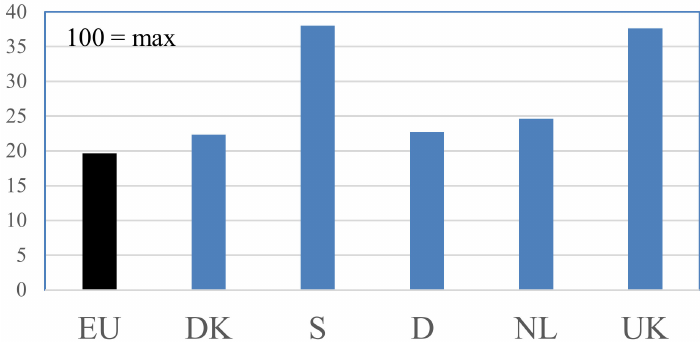
Figure 2. Comparison of aggregated Benchmark scores (on a scale from 0 to 100) for pig production in the five countries studied (both covering production just following national legislation and special, typically labelled, productions with extra welfare requirements). The score for the European Union (EU) represents what the Benchmark score would be if all production was based on the EU’s minimal requirements.